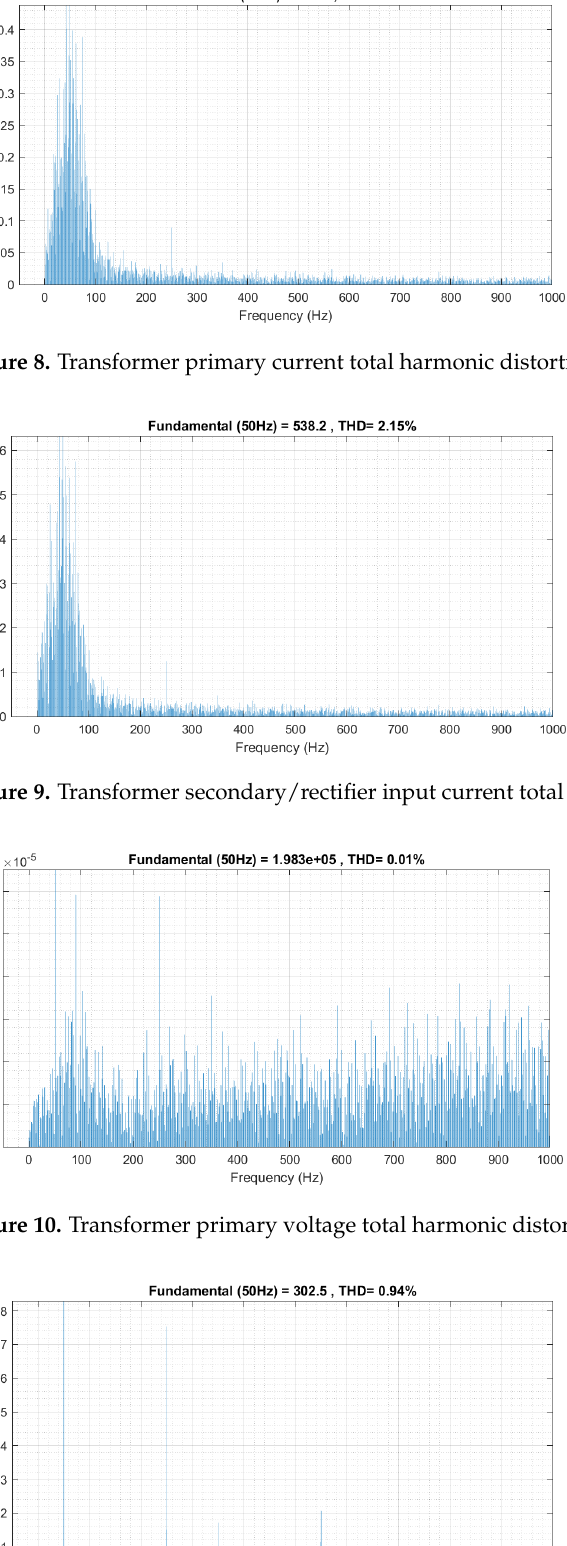
Figure 11. Transformer secondary/rectifier input voltage total harmonic distortion .